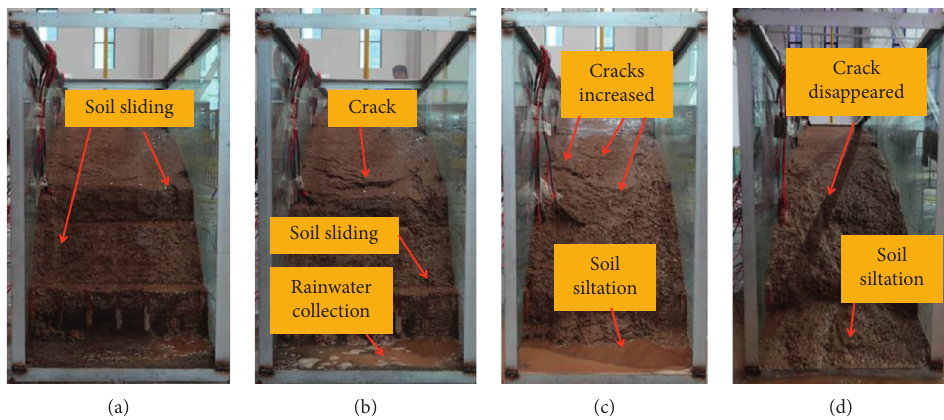
Figure 9: Summary of test phenomena. (a) 15 :45. (b) 16:10. (c) 17:10. (d) 18:30.